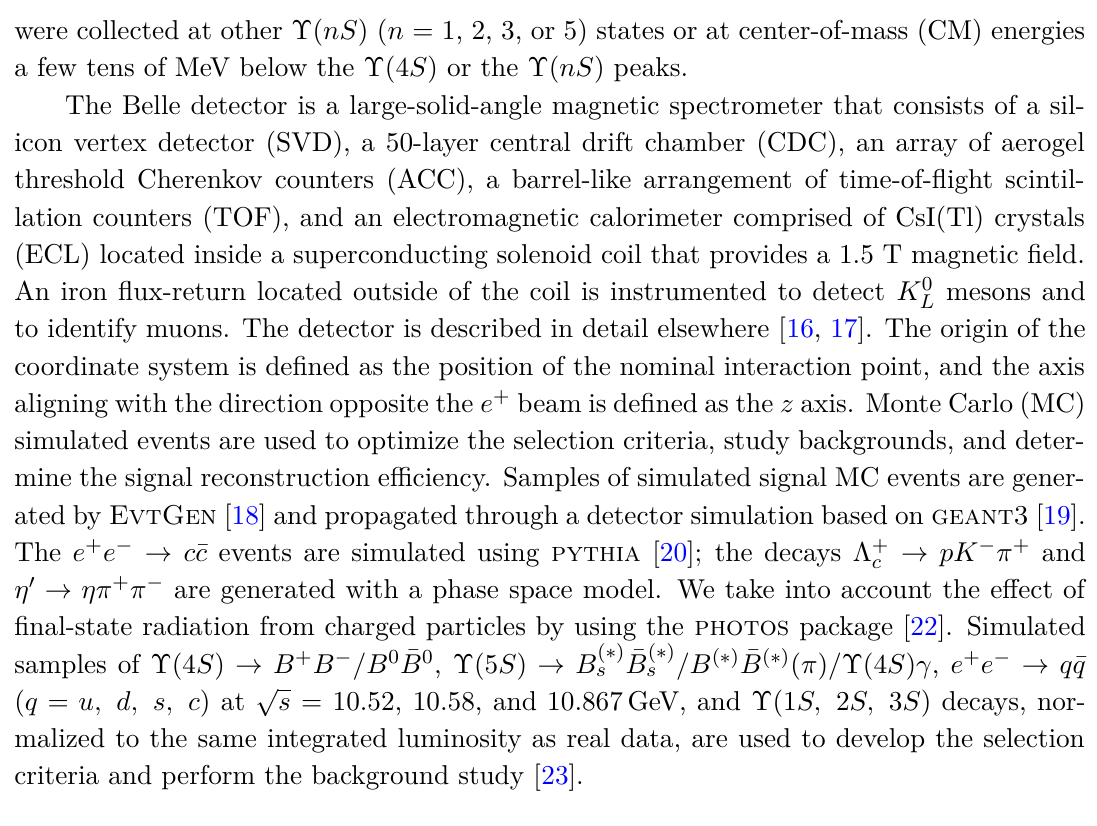
were collected at other Υ( nS ) ( n = 1, 2, 3, or 5) states or at center-of-mass (CM) energies a few tens of MeV below the Υ(4 S ) or the Υ( nS )